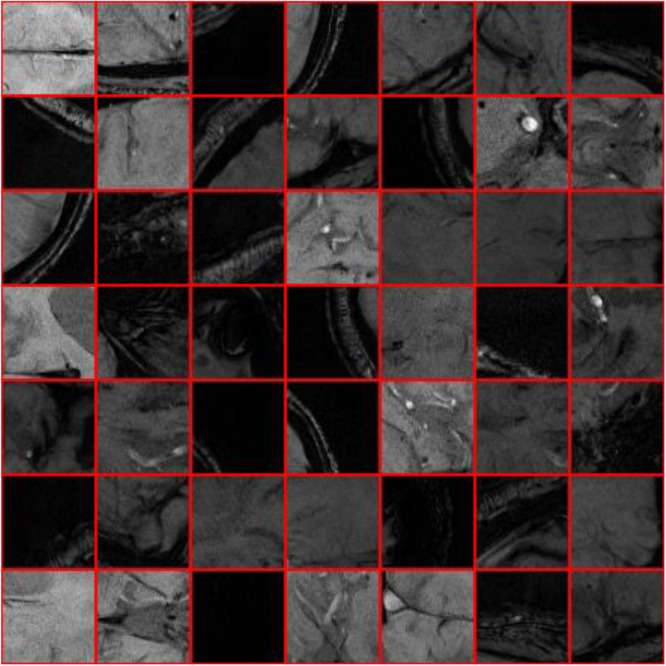
Non-CMB samples.